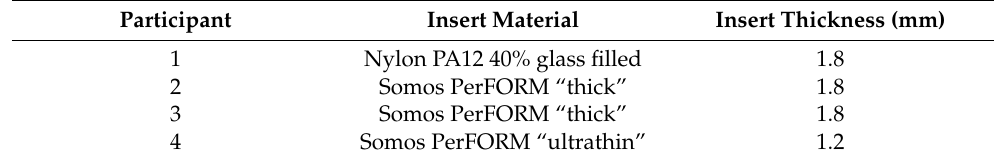
Table A2. Insert thickness for each